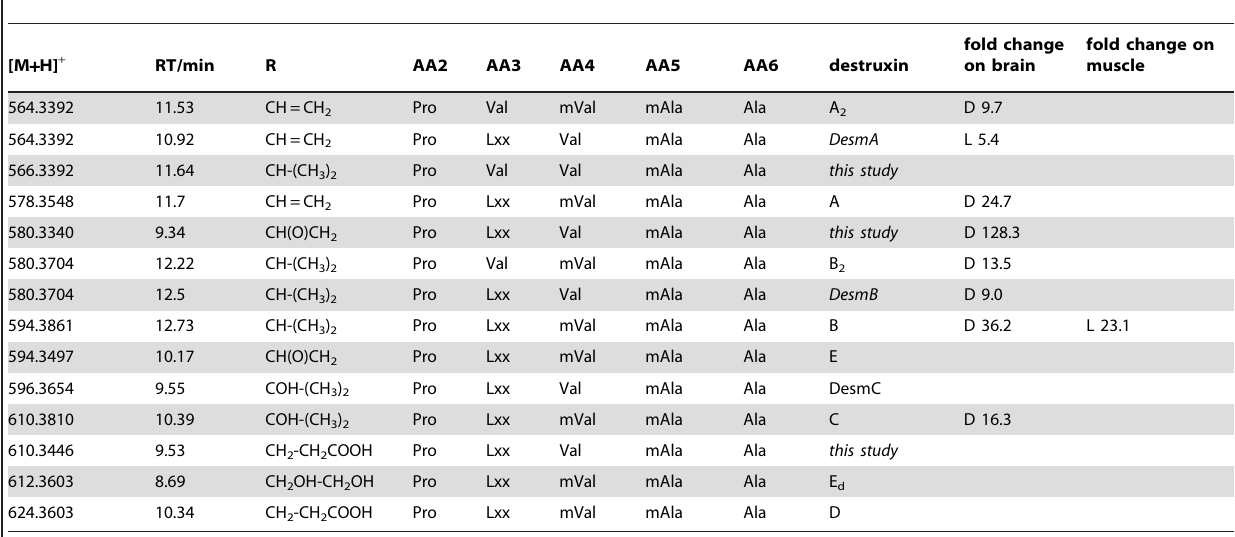
Table 2. Secreted destruxins in the ex vivo culturing